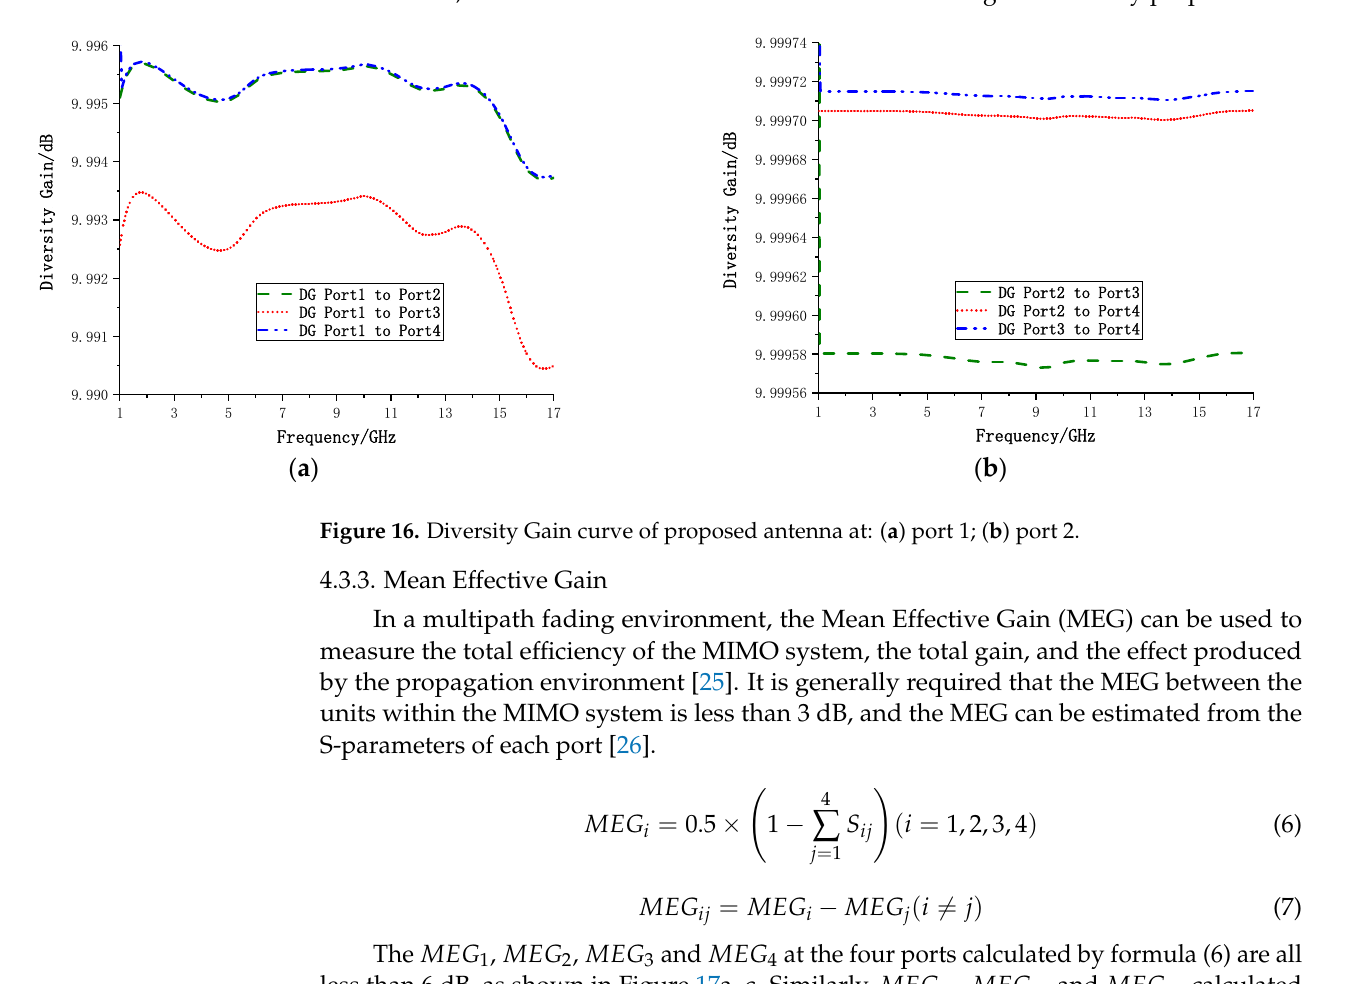
Figure 15. ECC between antenna units: ( a ) between port 1 and other ports; ( b ) between ports 2, 3, and 4.